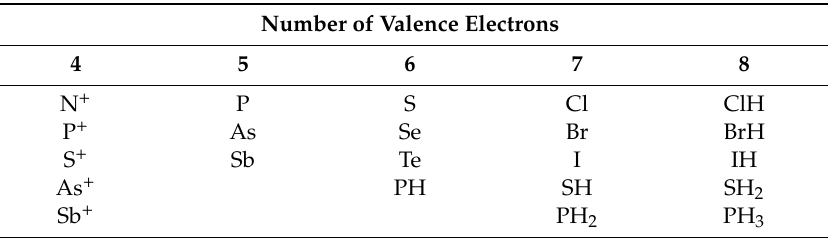
Table 2. Isosteres based on valence electron